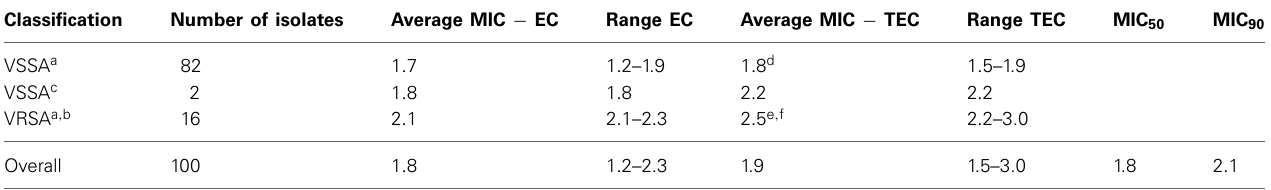
Table 1 | Minimum inhibitory concentrations (MIC) to vancomycin of porcine MRSA isolates by SGE. Classification